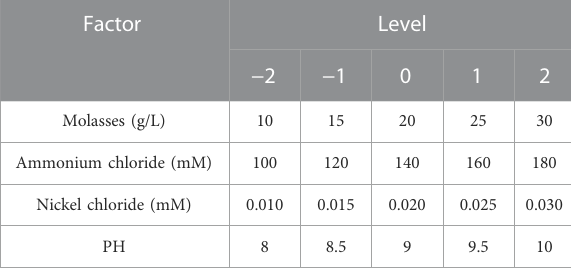
TABLE 3 Factors and levels of the CCD test. Factor